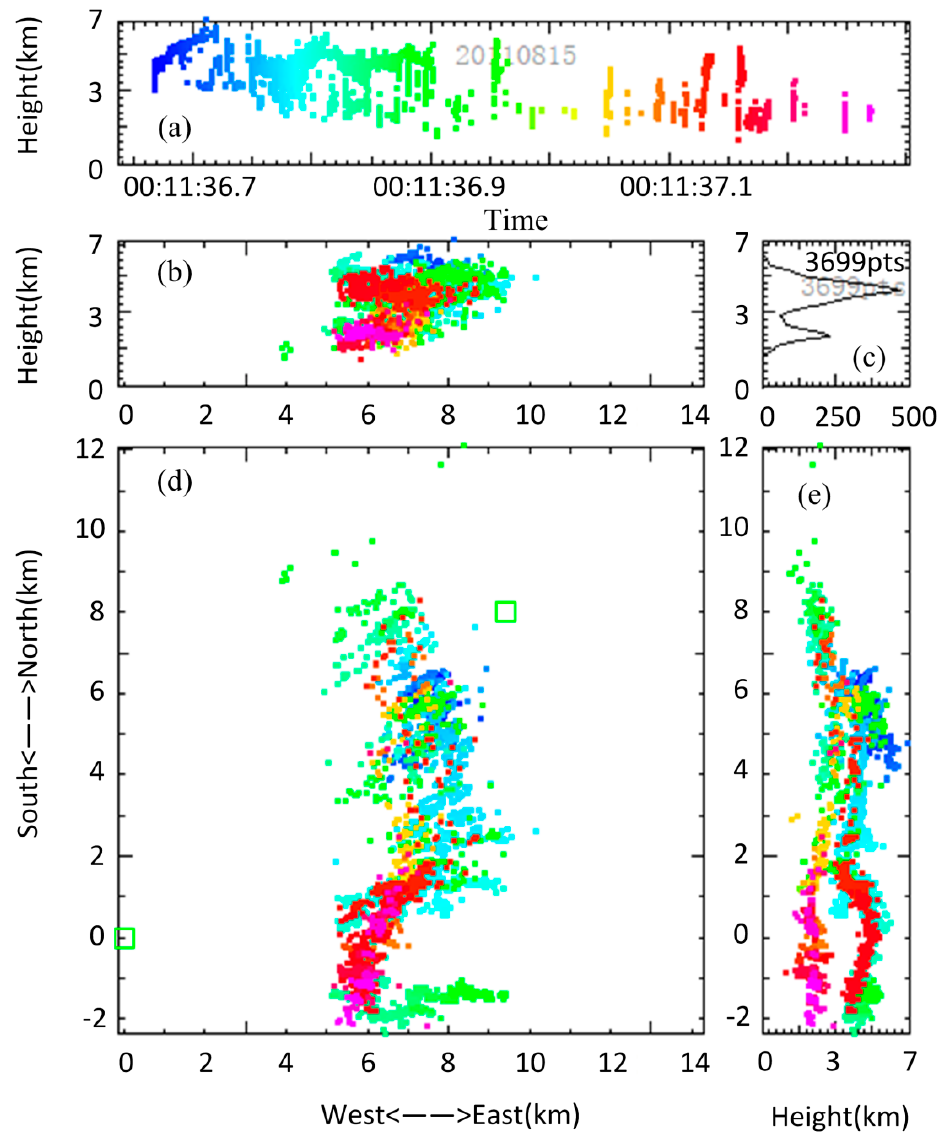
Figure 9. Location results for IC flash 001136 using the new method. In the figure, ( a ) the height of the radiation source changes with time, ( b ) the vertical projection of the east-west direction, ( c ) the number of radiation sources changes with the height, ( d ) the horizontal projection, and ( e ) the vertical projection of the north-south direction.